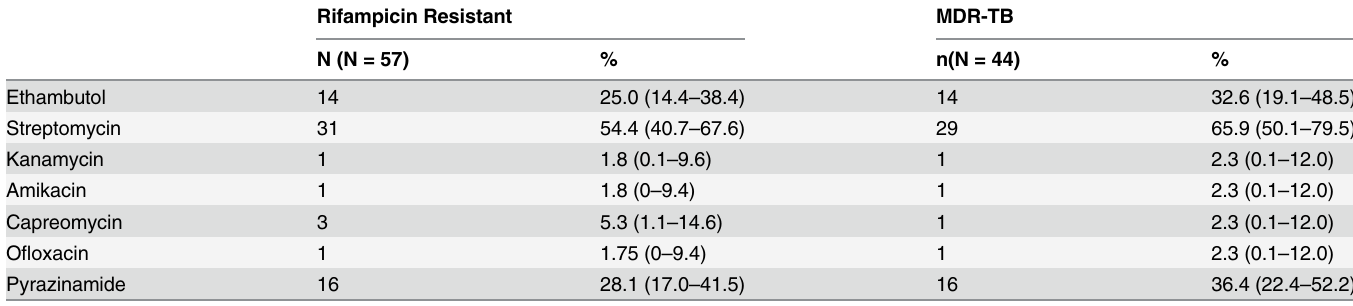
Table 2. Proportions of resistance to second-line anti-TB drugs among patients with rifampicin resistances in 4 provinces in PNG from Oct 2012 to Dec 2014.